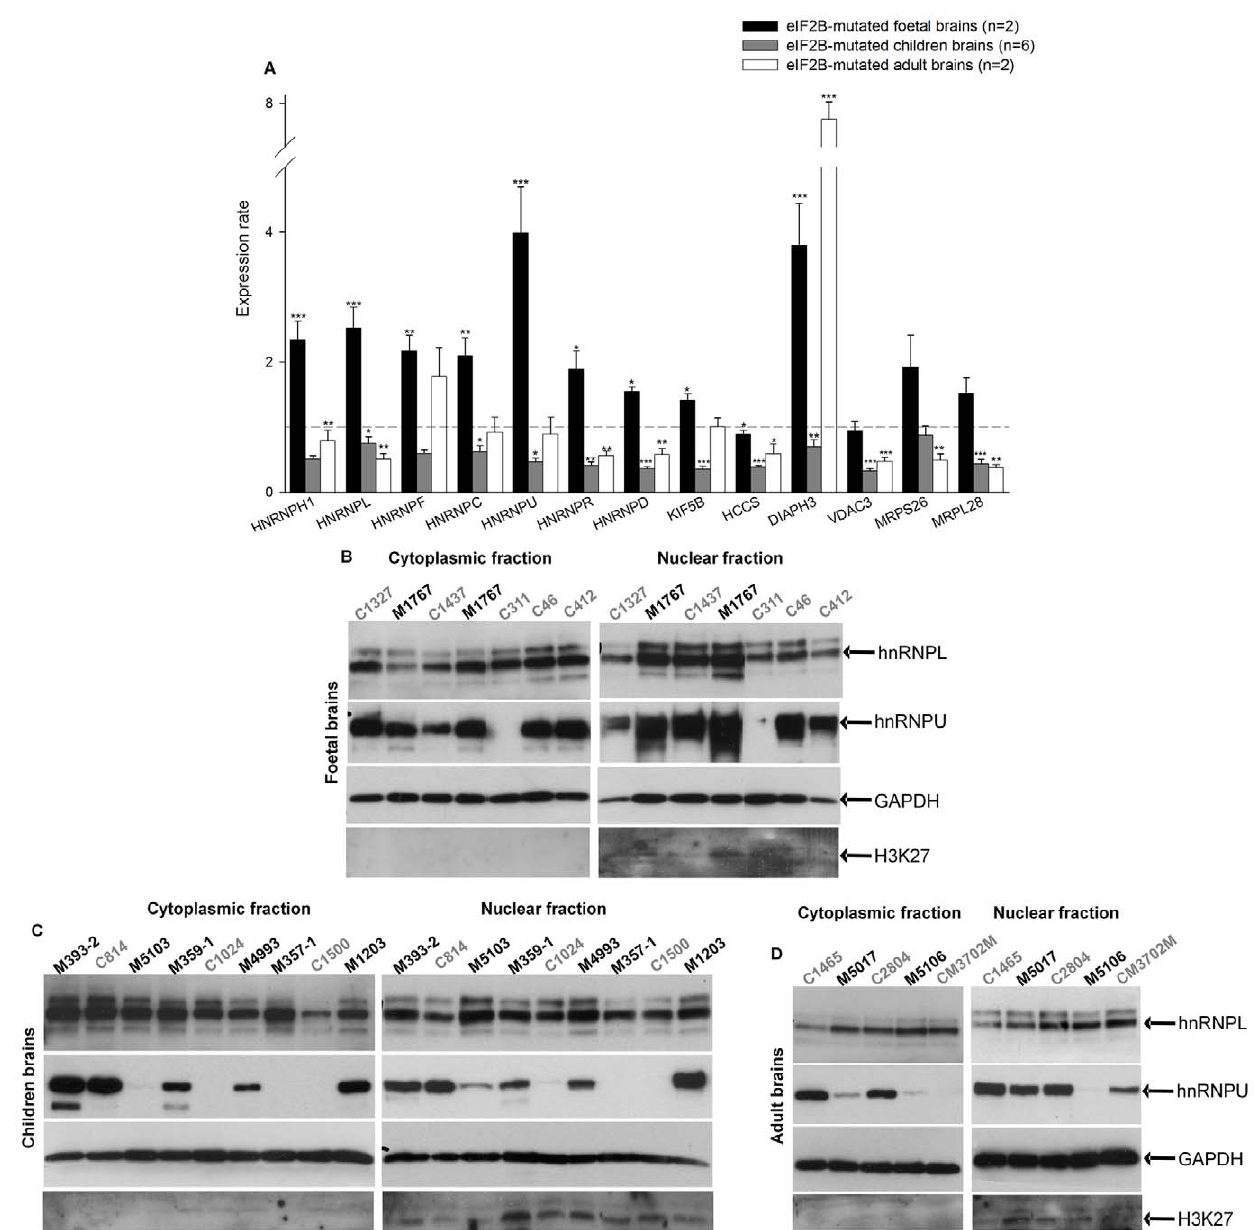
Figure 1. Expression rates of the 13 selected mRNA and two hnRNP proteins in eIF2B-mutated fœtal and patients brains. A. RNA was isolated from brains and analyzed by quantitative RT-PCR for expression of the 13 selected genes. Expression rates were calculated using the formula Mean (2 ‘ -(delta (patient)- delta (control))) where delta (patient) correspond to (Ct gene x 2 Ct B2M ) for one patient and delta (control) to (Ct gene x 2 Ct B2M ) for the corresponding control. Errors bars represent standard error (s.e.m.) (* P , 0.05, ** P , 0.01, *** P , 0.001). B–D. To assess the expression of hnRNPL and hnRNPU proteins in the brain autopsy samples, a nuclear and cytoplasmic differential extraction were performed followed by western blot analysis using antibodies specific for hnRNPL and U. GAPDH served as loading control. H3K27 served as a nuclear control. Are represented in B the fetuses samples, in C the children samples and in D the adults samples. C: control, M: eIF2B-mutated.